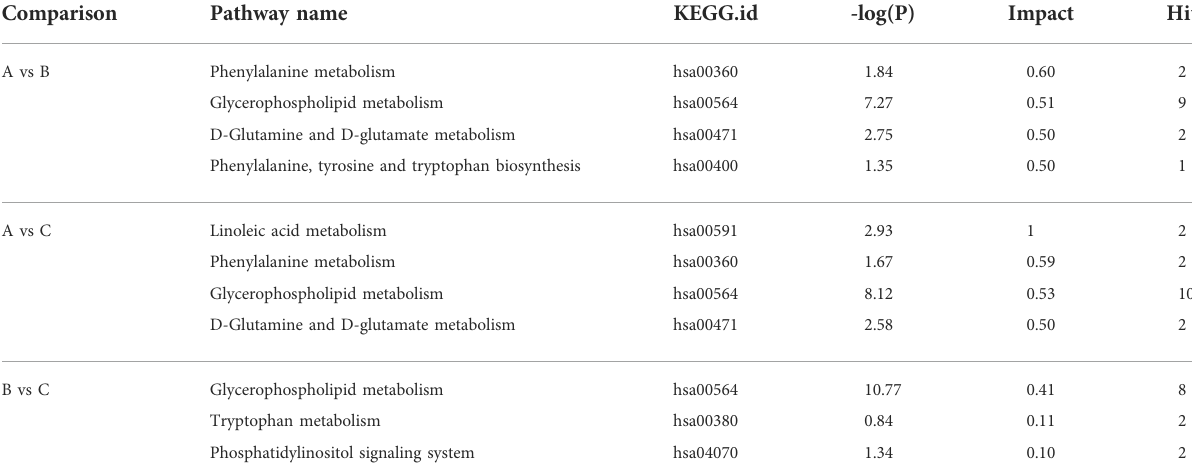
TABLE 5 Signi fi cantly altered metabolic pathways in A vs B, A vs C and B vs C comparisons.